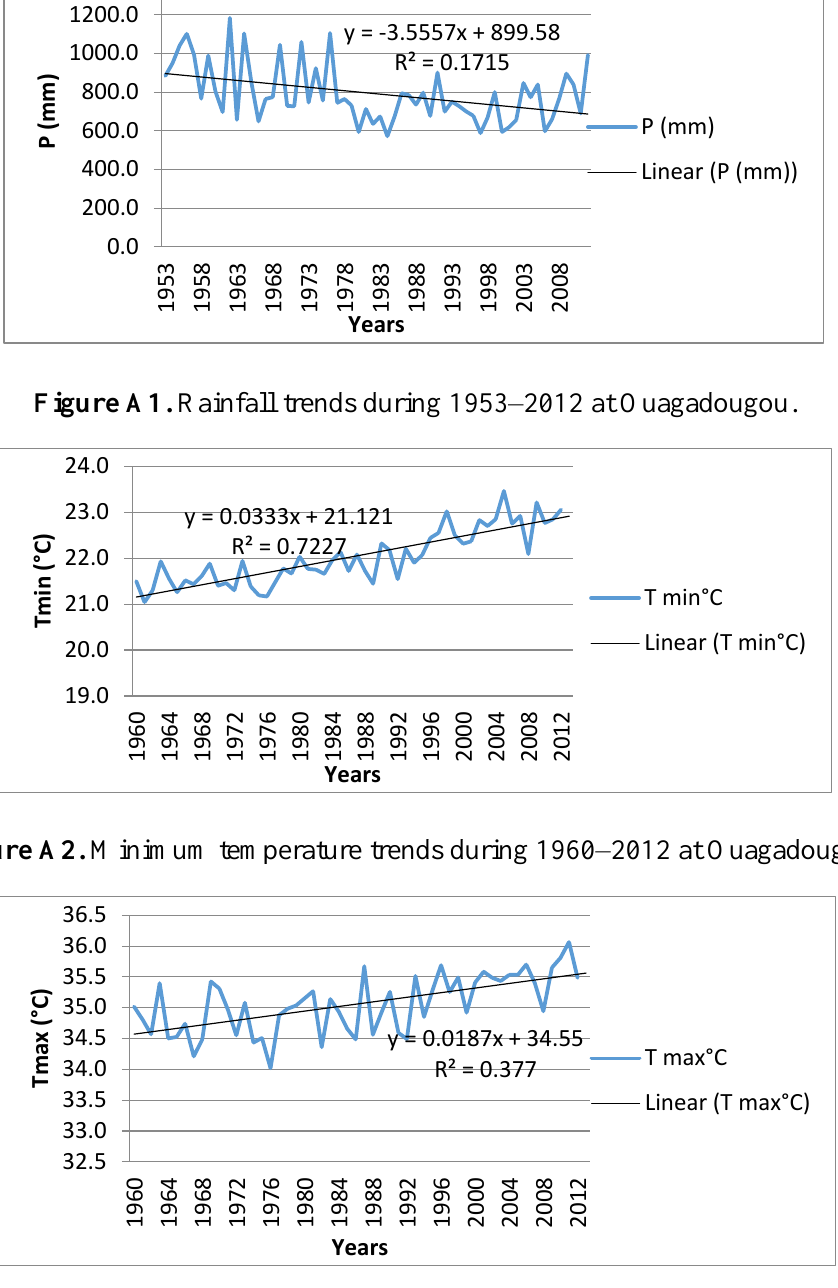
Figure A3. Maximum temperature trends during 1960–2012 at